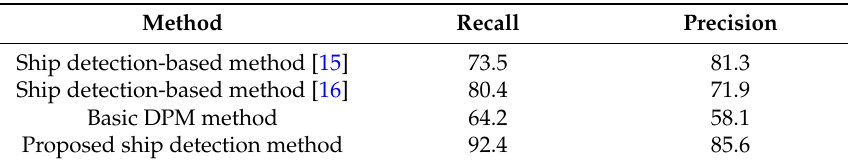
Table 1. Detection Results of Different Methods.